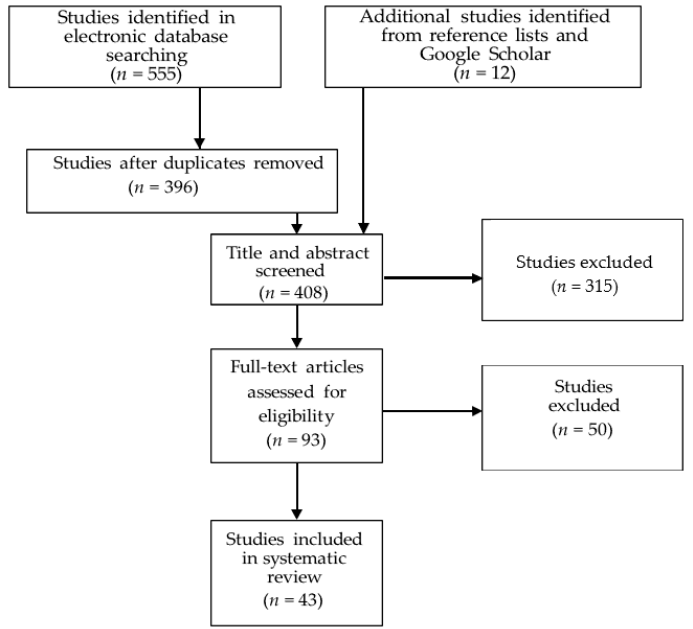
Figure 1. Selection process of studies for this review.